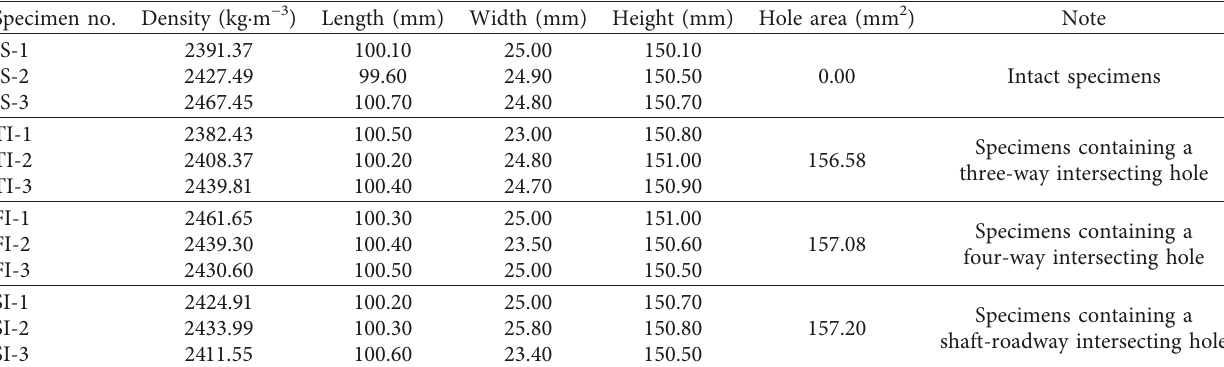
Figure 1: Simplified schematic of the three-dimensional intersection structures by the plane stress assumption: (a) TI; (b) FI; (c) SI. Table 1: Basic parameters of